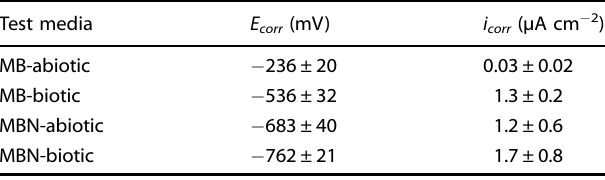
Fig. 8 Potentiodynamic polarization curves for creviced 304 stain- less steel coupons at the end of OCP tests. Potentiodynamic polarization scans taken at a scan rate of 0.166 mV s − 1 from − 250 mV to 1500 mV versus OCP in different test media under abiotic and biotic conditions at 30 °C. Table 1. Electrochemical parameters obtained from potentiodynamic polarization curves.